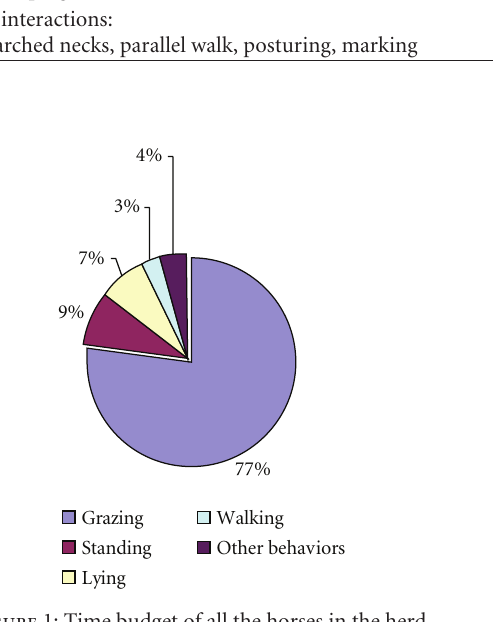
Figure 1: Time budget of all the horses in the herd.